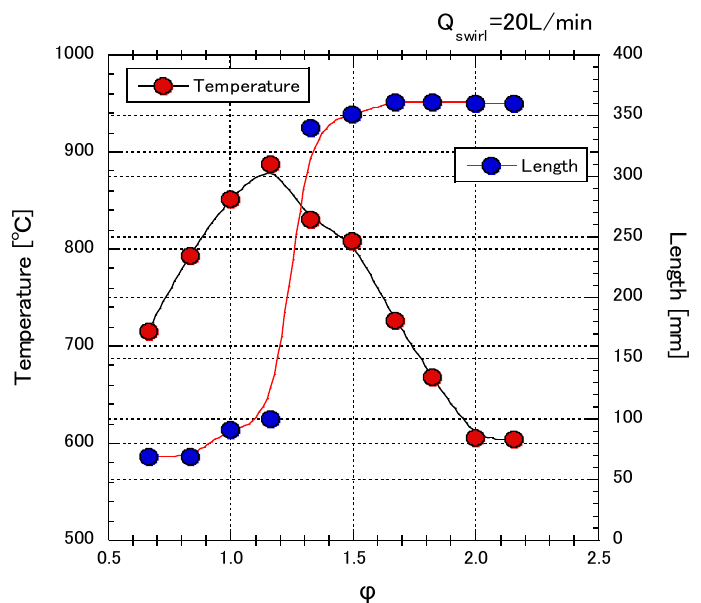
Figure 16. Relationship between the equivalent ratio when the fuel flow is changed, the combustion chamber temperature, and the flame length (Q swirl = 20 L/min fixed).